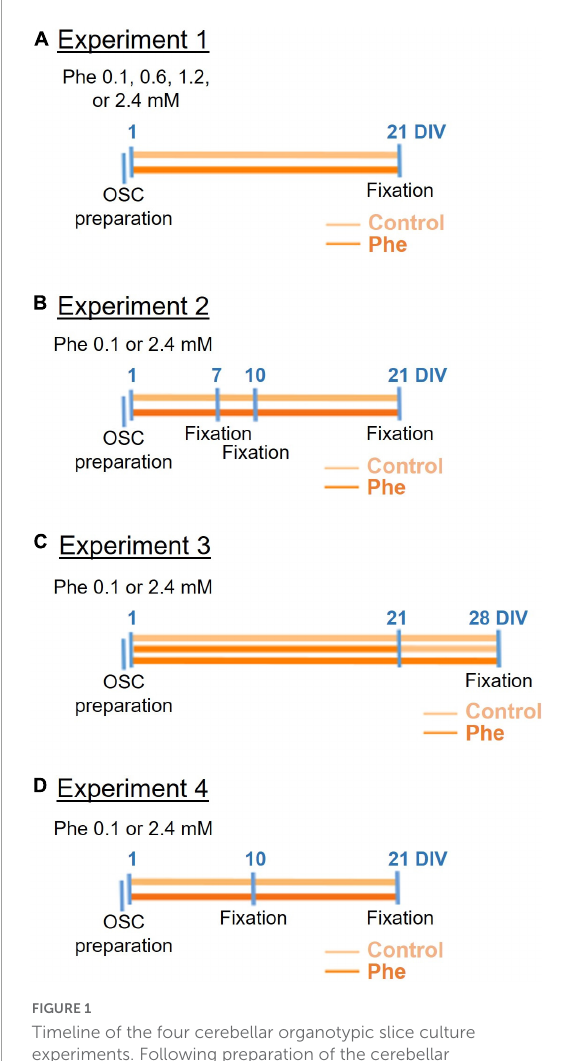
FIGURE1 Timeline of the four cerebellar organotypic slice